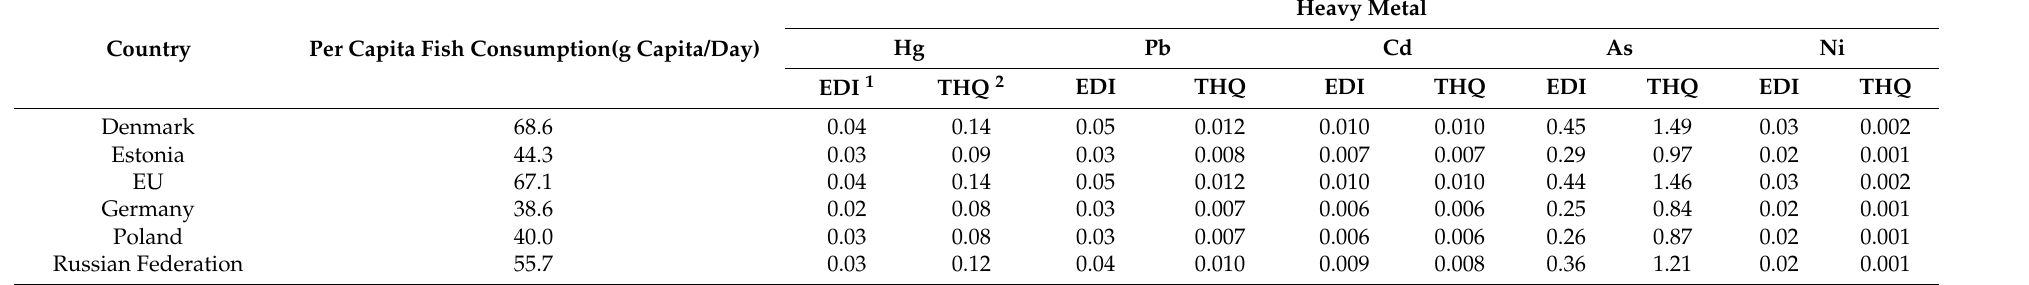
Table 4. Health risk assessment of heavy metals for fish consumption ( µ g/kgBW/day) [33–36].